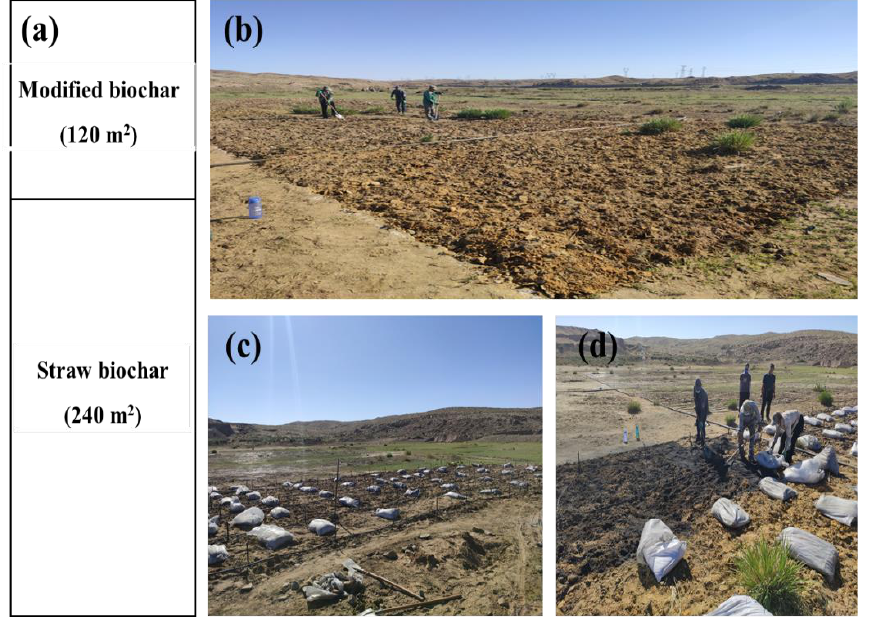
Figure 3. Biochar-stabilization and biochar application: ( a ) plot of the biochar-stabilization zone, ( b ) cultivation of the soil in the biochar-stabilization zone, ( c ) transport of biochar, ( d ) artificial mixing of biochar, and top soil.